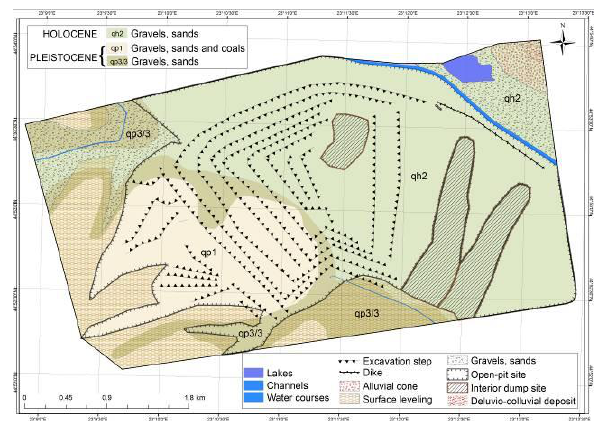
Figure 2. Geological map of the Rosia Jiu open pit